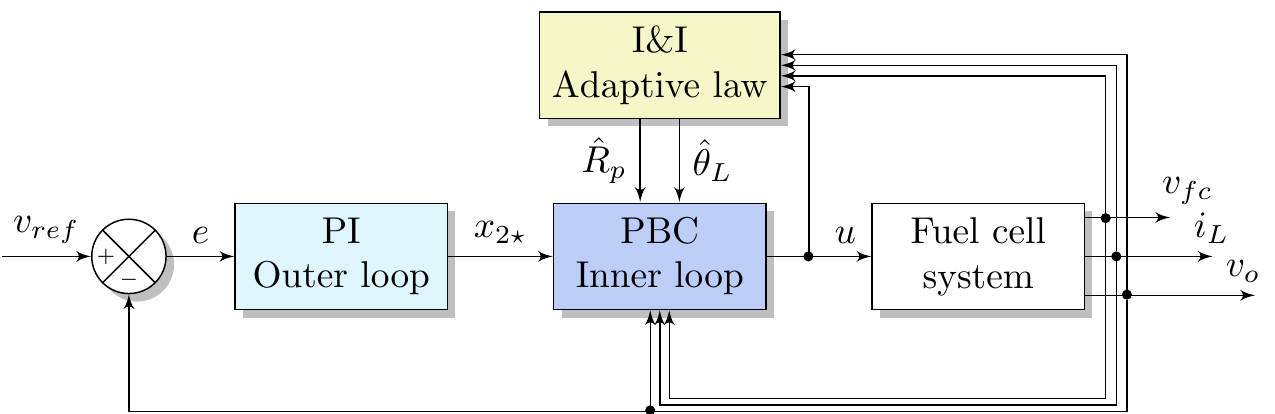
Figure 4. Block diagram of the E-L-PBC-based adaptive multi-loop controller.